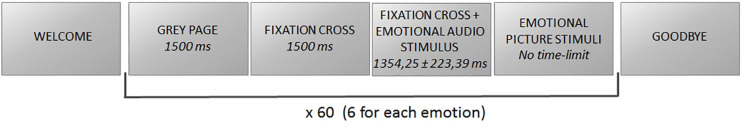
Scheme of the experimental protocol.